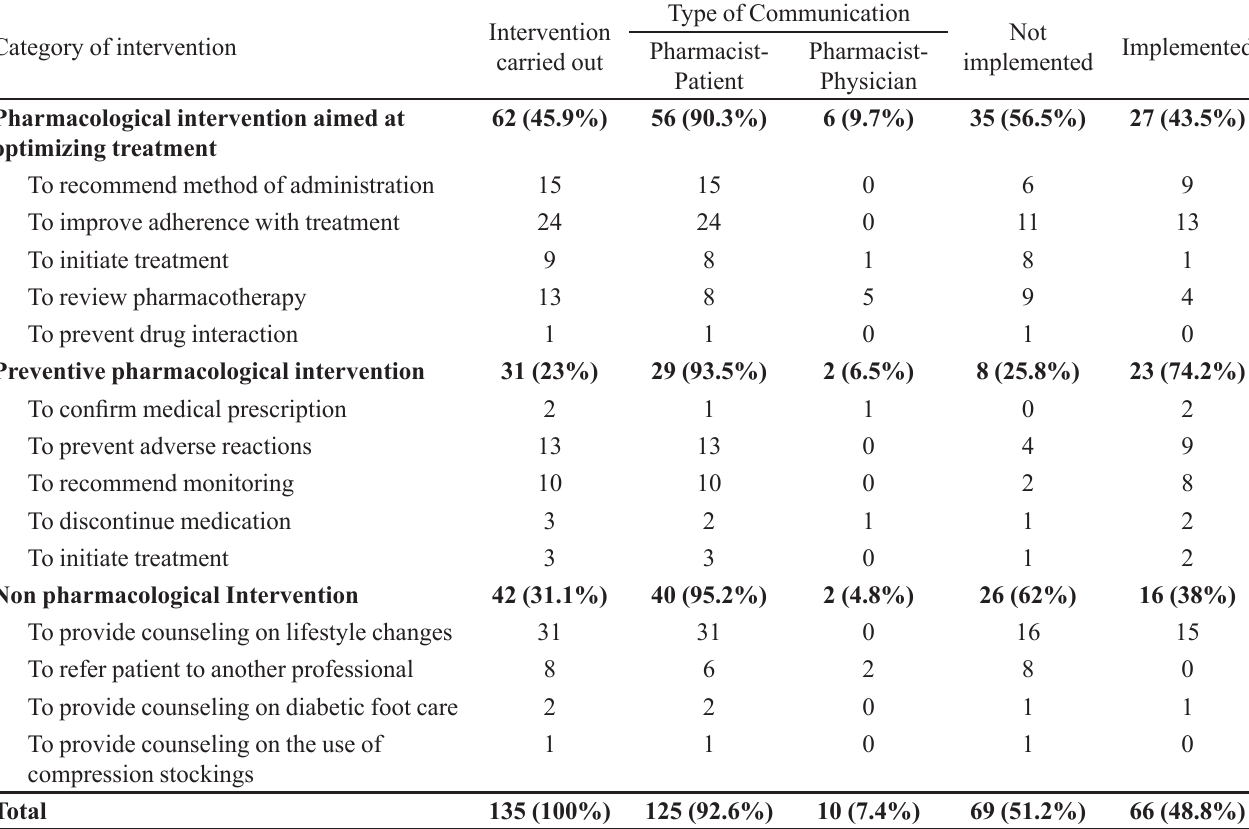
TABLE II - Description of the pharmaceutical interventions carried out during the study